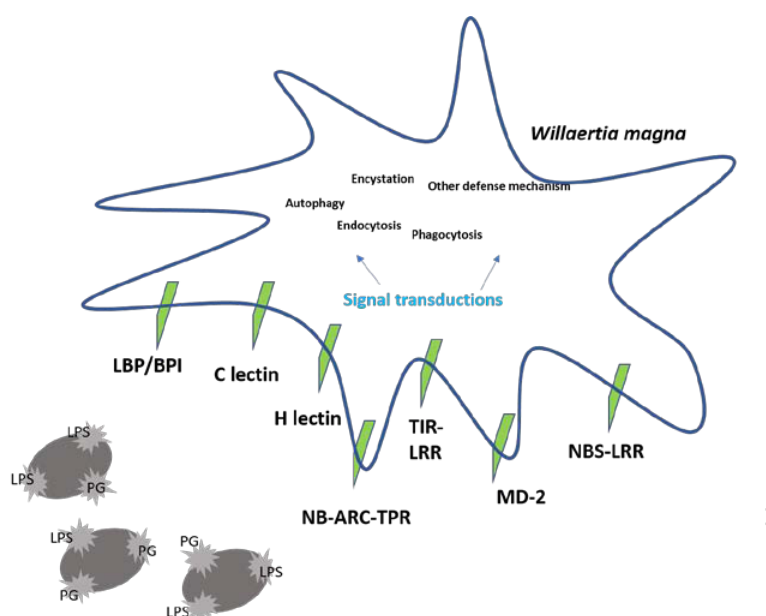
Figure 5. Mechanism of pattern recognition and pattern-recognition receptors (PRRs) identified within Willaertia magna : Lipopolysaccharide (LPS), Proteoglycan (PG), Lipopolysaccharide binding protein / Bactericidal Permeability-Increasing protein (LPS / BPI), C-lectin, H-lectin, Nucleotide-Binding Adaptor R-gene and Tetratricopeptide Repeat (NB-ARC-TPR), Toll / Interleukin-1 Receptor and Leucine-Rich Repeat (TIR-LRR domain), Nucleotide Binding Site and Leucine Rich Repeat (NBS-LRR domain) and MD-2.